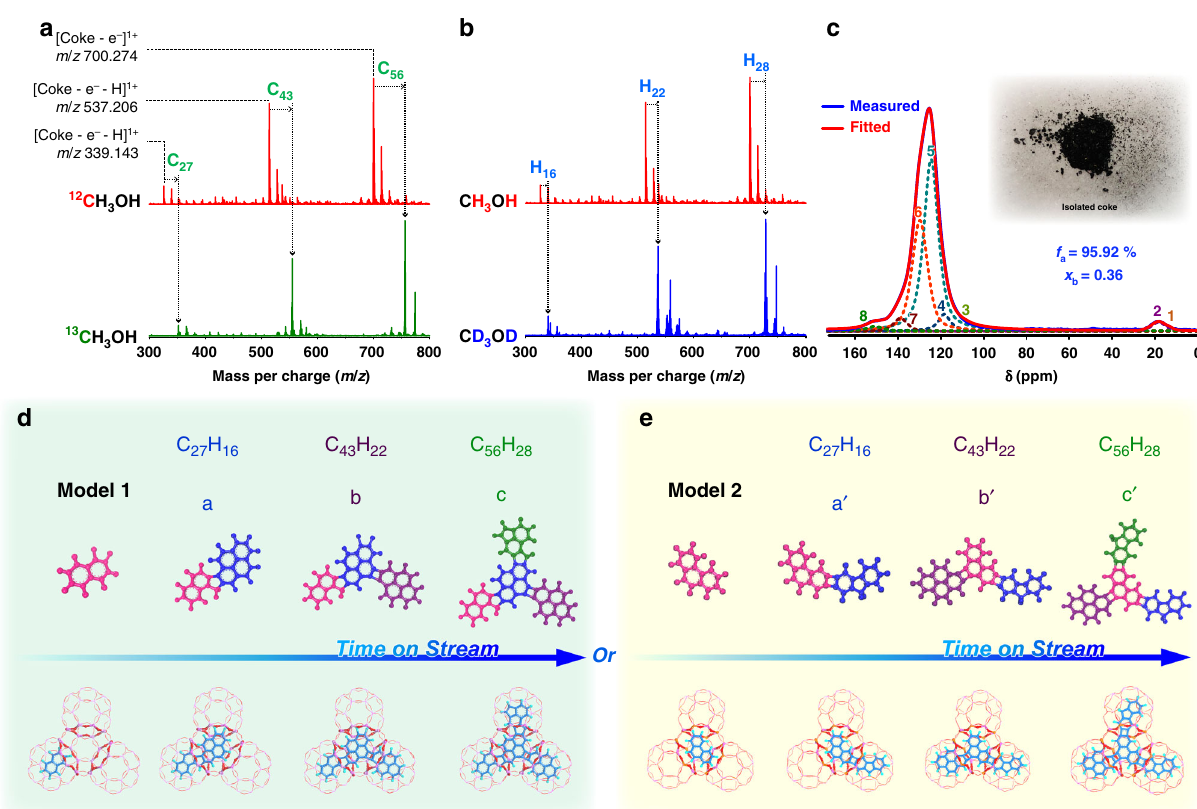
Fig. 4 The structural identi fi cation of PAHs. MALDI FT-ICR mass spectra of the extracts from the spent SAPO-34 after 130 min reaction at 475 °C for comparing the feeding of 13 C-methanol ( a ) and D-methanol ( b ) with normal methanol. c 13 C solid-state nuclear magnetic resonance (ssNMR) spectroscopy of the isolated insoluble coke. The spectrum was recorded at a spin rate of 110 kHz. The morphology of isolated coke was shown in Supplementary Fig. 8. d , e The identi fi ed conceivable molecular structures of PAHs with optimized con fi guration (Model 1 and Model 2) by periodic DFT calculations and their evolving routes. The con fi gurational optimization was shown in Supplementary Fig. 9. Although with the precise C x ( a ) and H y ( b ) that give the precise chemical composition of each PAH (C x H y ), the diversity of isomers would lead to multiple molecular structure. Fortunately, in view of the connectivity and dimensions of cha cages, some different isomers have been excluded. Here we stress that the illustrative examples of molecular structure are certainly not absolute, and they highlight the concept of cage-passing growth of